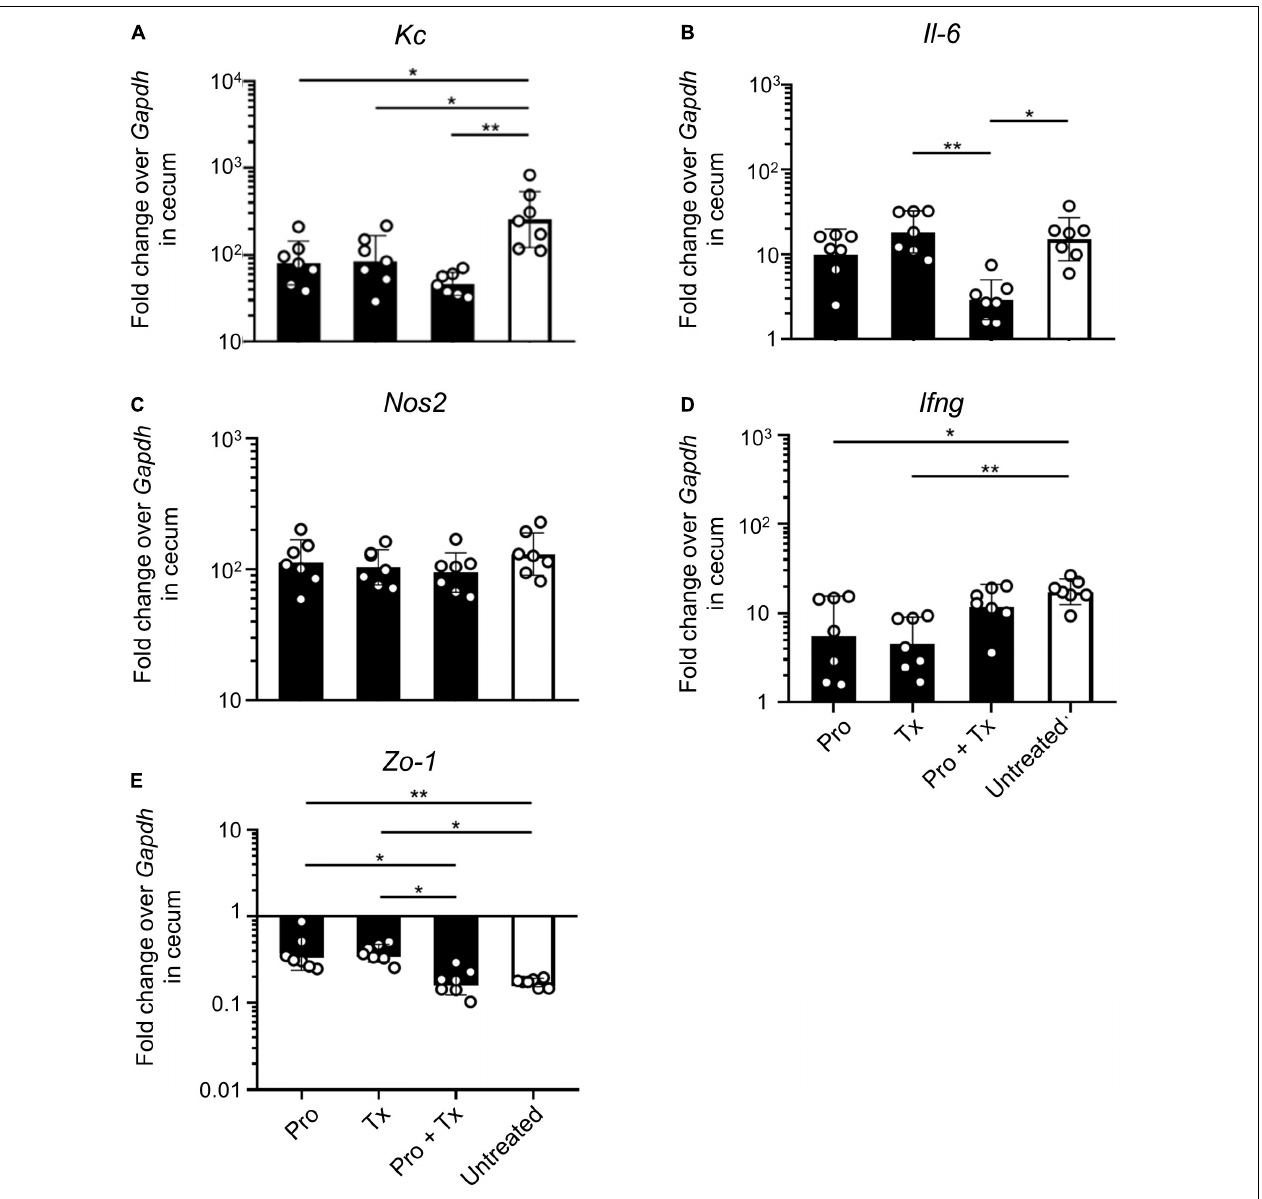
FIGURE 5 | Anti-inflammatory effect of L. reuteri KUB-AC5 on the STM-infected mouse cecum. At day 4 post infection, mouse ceca were collected and quantified for the fold change in mRNA expressions of pro-inflammatory cytokines ( Kc , Il-6 , and Ifng ), iNOS ( Nos2 ), and tight junction protein ( Zo-1 ) by qPCR. All genes were analyzed with the comparative Ct method over the housekeeping gene Gapdh . Bars represent geometric means ± SD. * P < 0.05 and ** P < 0.01 compared to all other